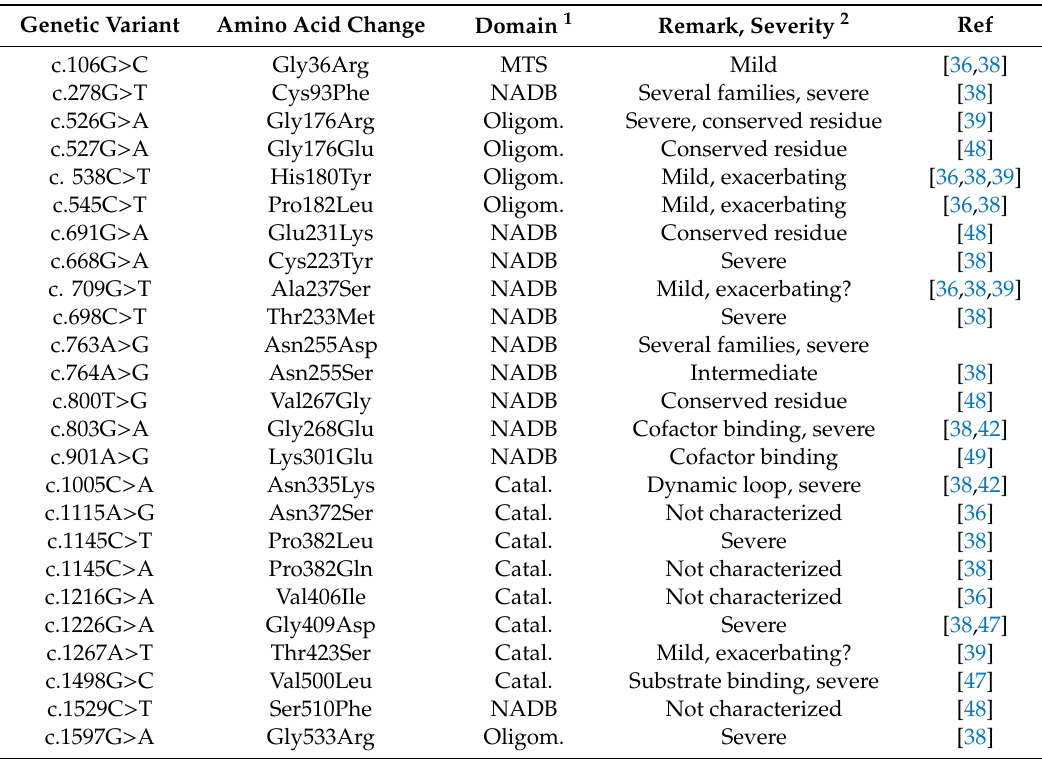
Table 2. Selected missense variants of the human ALDH5A1 gene that have been associated